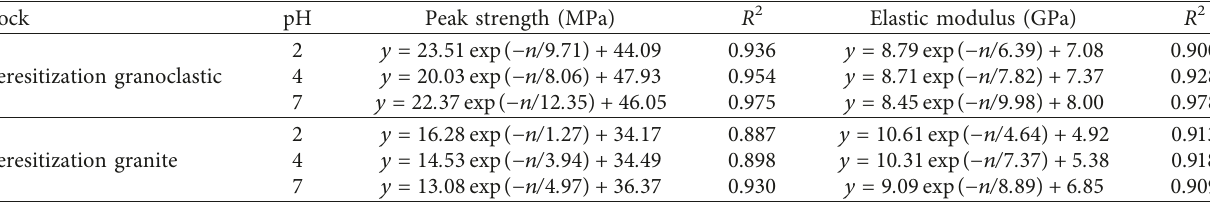
Table 4: The fitting expression between mechanics parameters and cycles.